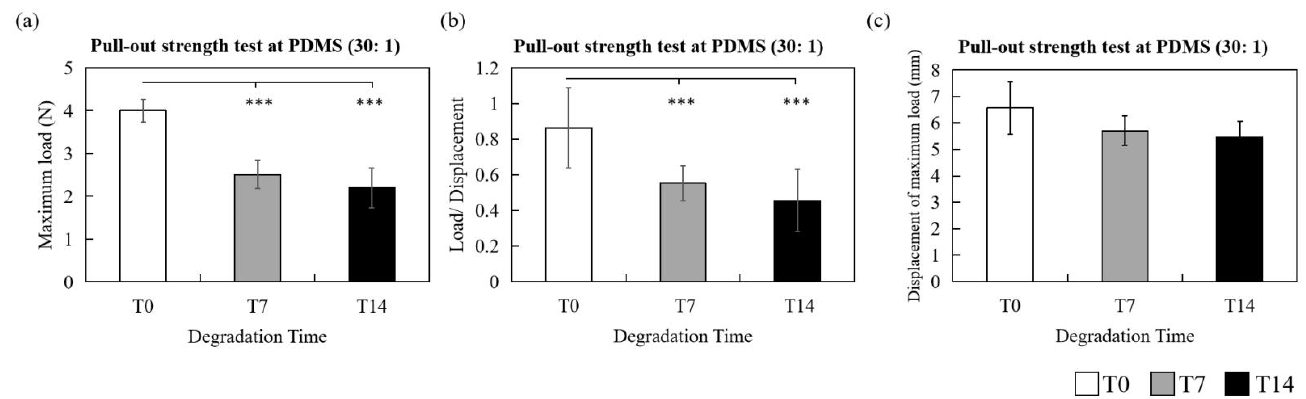
Figure 5. Comparison of ( a ) average maximum load (N), ( b ) load/displacement and ( c ) average displacement of maximum load (mm) of T0 (white bars), T7 (gray bars) and T14 (black bars) samples by pull-out test with PDMS (30:1) specimens. *** p < 0.001 when compared with T0 samples.